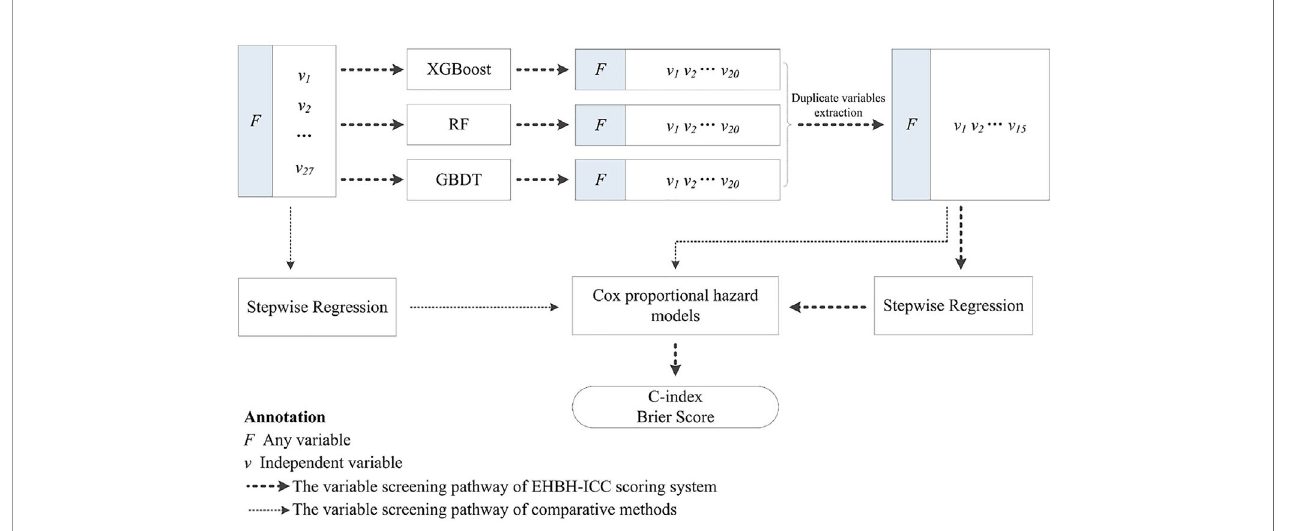
FIGURE 1 | The work fl ow of this